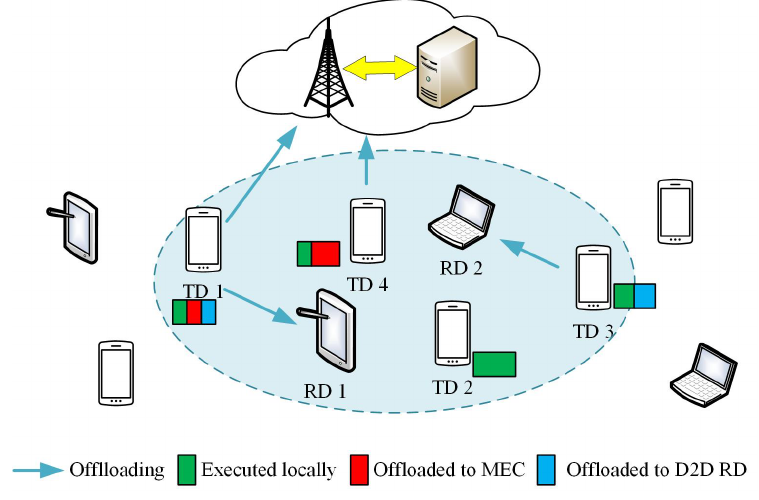
Figure 1. Network